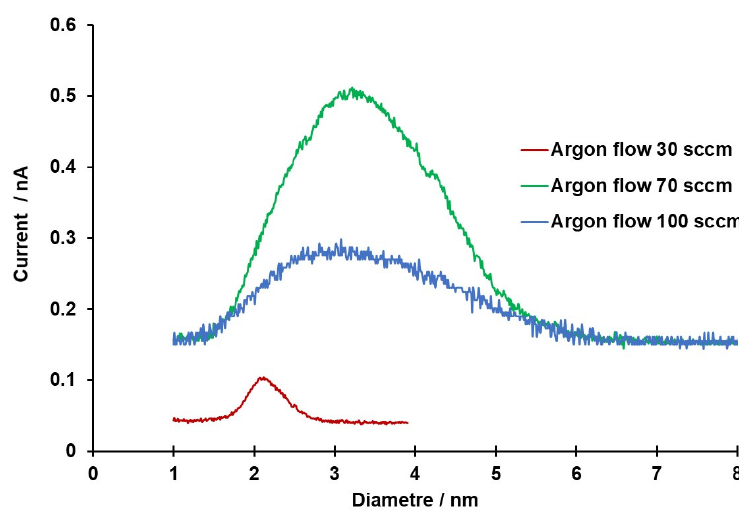
Figure 2. Comparison of spectra according to argon flow rate. Therefore, by adjusting the sputtering conditions, the process can be repeated to obtain IONPs with the desired dimension and size distribution.